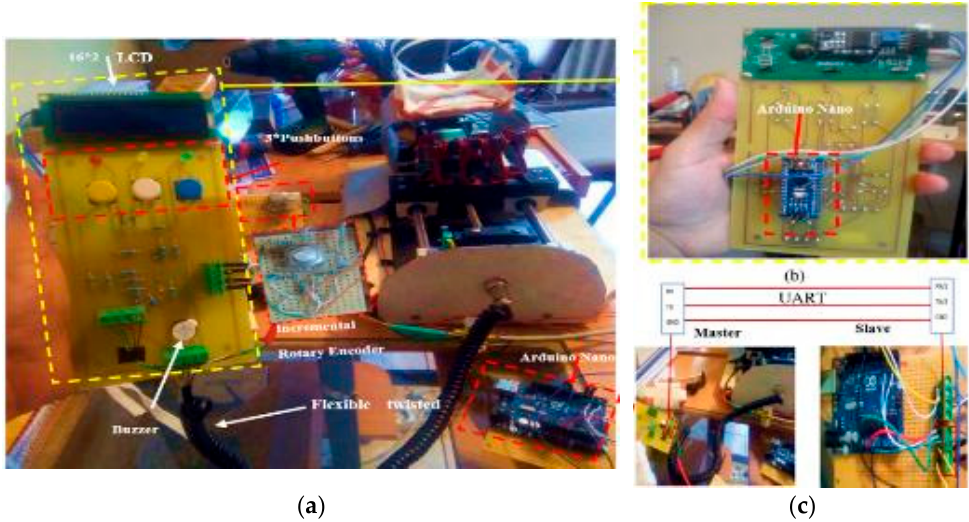
Figure 8. Hardware implementation and PCB design of the portable control unit, ( a ) front view of the hardware step-up; ( b ), back view of the portable control unit; ( c ) The serial communication (UART) between two microcontrollers: Arduino Nano (Master) TX pin, transmits the serial data including selected therapy control parameters to other Arduino Uno (Slave) RX pin which, once the therapy is executed then RX and TX pins of each Arduino vice versa send back.